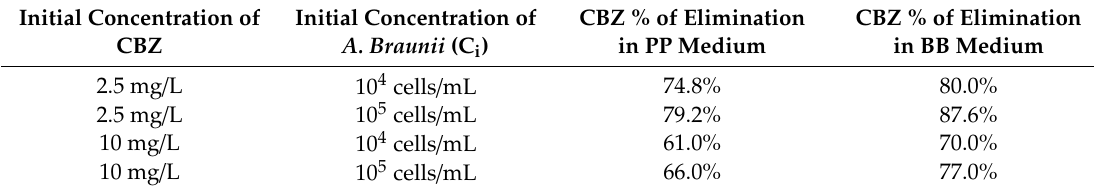
Table 3. Removal yield of CBZ determined by HPLC for an initial CBZ content between 2.5 and 10 mg/L, and an inoculum concentration between 10 4 and 10 5 cells/mL after 60 days. Initial Concentration of